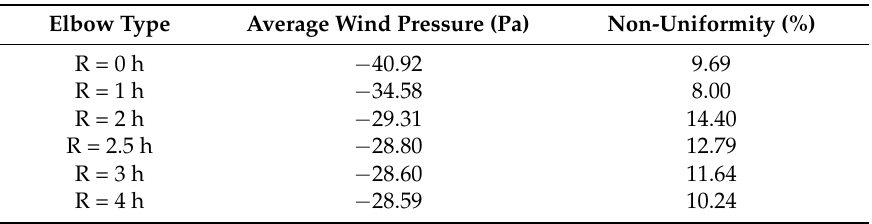
Table 4. Wind pressure distribution and